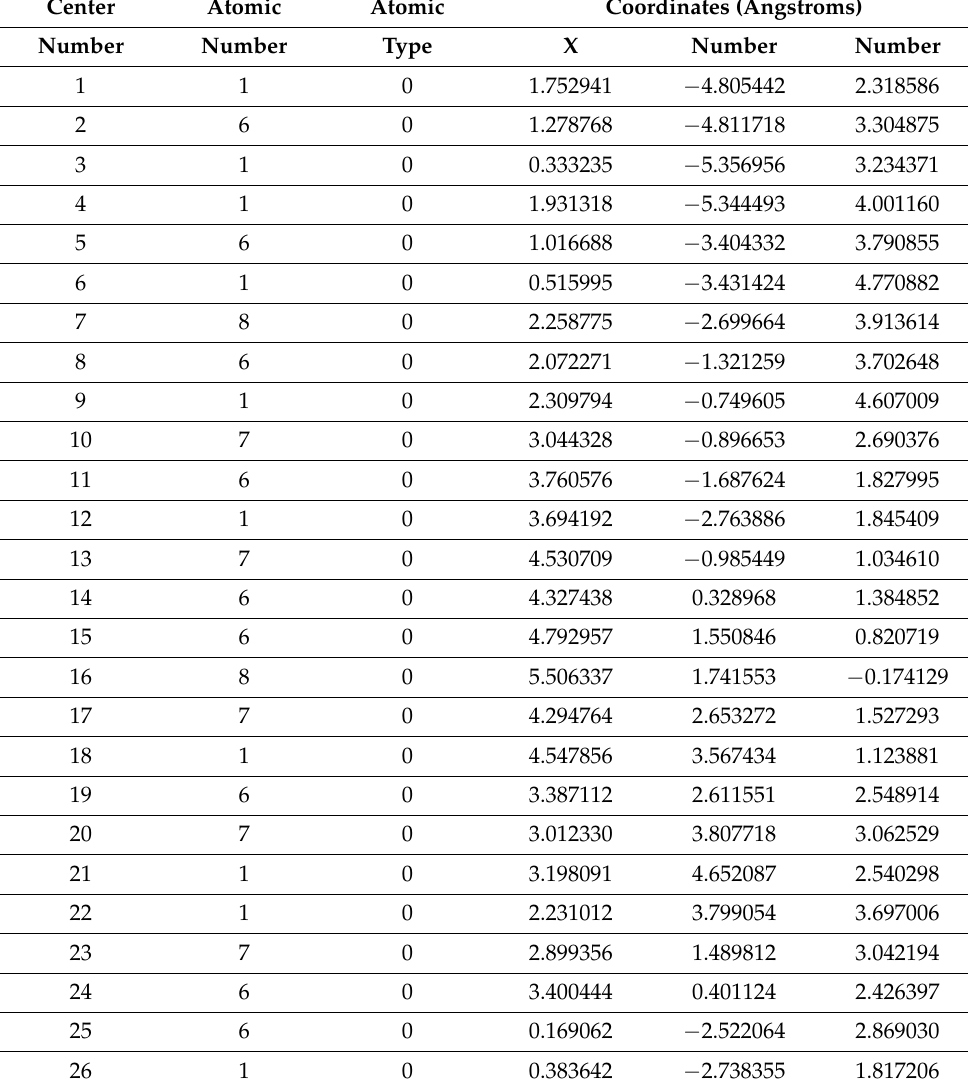
Table A10. Complex LiI 3 with nucleotide triplet CGG. Framework group C1[X(C29H37I3LiN13O15P2)]. Deg. of freedom 294. Standard